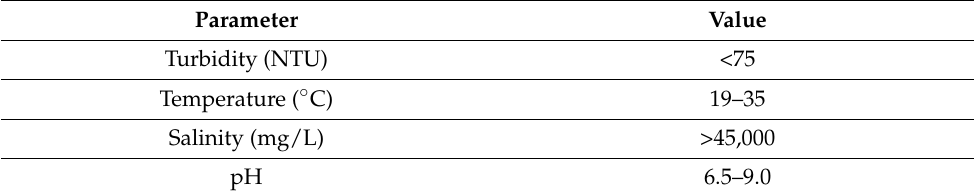
Table 2. General characterization of seawater in the UAE [26].